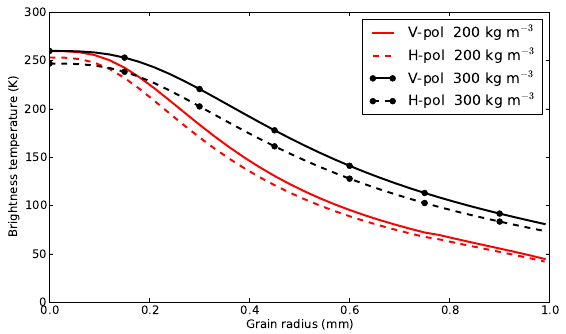
Fig. 5. Brightness temperature at 89GHz, 53 ◦ incidence angle, ho- rizontal and vertical polarizations (dashed and solid line, respec- tively) as a function of the grain size with a density of 200 (red) and 300kgm − 3 (black).